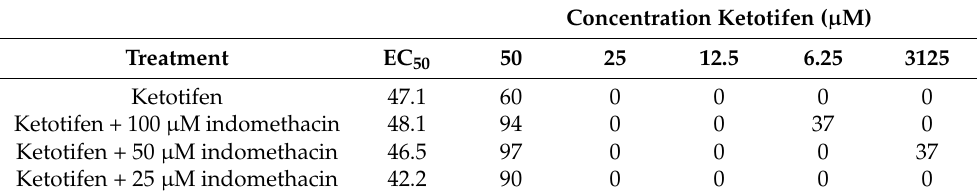
effect. reveals that, compared to ketotifen alone (60% inhibition at EC 50 ), an increase in percentage Table 3. EC 50 and percentage inhibition of SARS-CoV-2: 50 μ M ketotifen in combination with indomethacin. Table 3. EC 50 and percentage inhibition of SARS-CoV-2: 50 µ M ketotifen in combination with indomethacin.